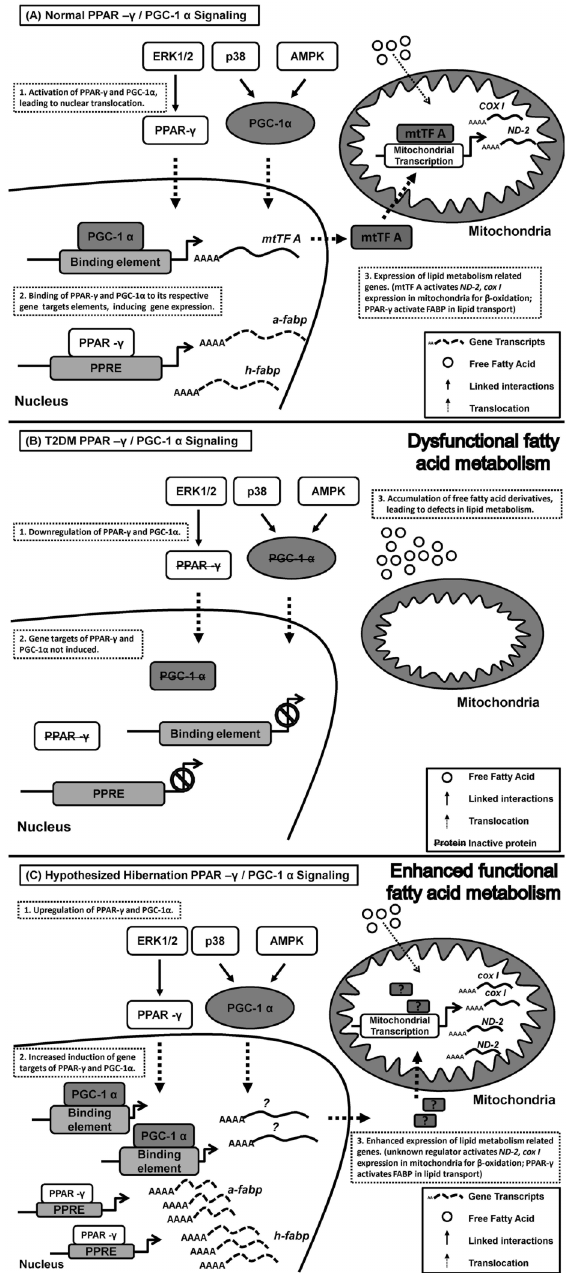
Figure 2. PPAR- c /PGC-1 a signaling pathways. Activation of PPAR- c through upstream kinase cascades leads to the nuclear translocation of the transcription factor. The binding of PPAR- c onto peroxisome proliferator response elements (PPRE) pro- motes the expression of genes involved in fatty acid transport such as a-fabp and h-fabp . Similar to PPAR- c , activation of PGC- 1 a via upstream kinases facilitates the nuclear translocation of PGC-1 a . Upon interacting with various potential binding partners, PGC-1 a stimulates the expression of mitochondrial transcription factor A (mtTFA). mtTFA subsequently translocates into mito- chondria and activates expression of ND-2 and cox I , genes that are involved in the mitochondrial fatty acid oxidation process. A , Normal PPAR- c /PGC-1 a signaling. B , T2DM PPAR- c /PGC-1 a signaling. Downregulation/dysfunctional PPAR- c and PGC-1 a protein expression in T2DM results in the dysregulation of their respective functions. These defects result in the downregulation of PPAR- c /PGC-1 a downstream target genes, leading to the loss of mitochondrial oxidation capacities. The decrease in mitochon- drial fatty acid oxidation results in the dysfunction of fatty acid metabolism, leading to the accumulation of free fatty acids. C , Hibernation PPAR- c /PGC-1 a signaling. The reversible activation of lipid-based metabolism during hibernation is supported by an enhanced PPAR- c and PGC-1 a protein expression. Through unidentified regulators, the upregulation of PGC-1 a results in the activation of ND-2 and cox I , two mitochondrial genes that are critical in the mitochondrial fatty acid b -oxidation process. The upregulation of PPAR- c during hibernation leads to the promotion of A-FABP and H-FABP, isoforms of fatty acid-binding proteins that facilitate and enhance lipid transportation during